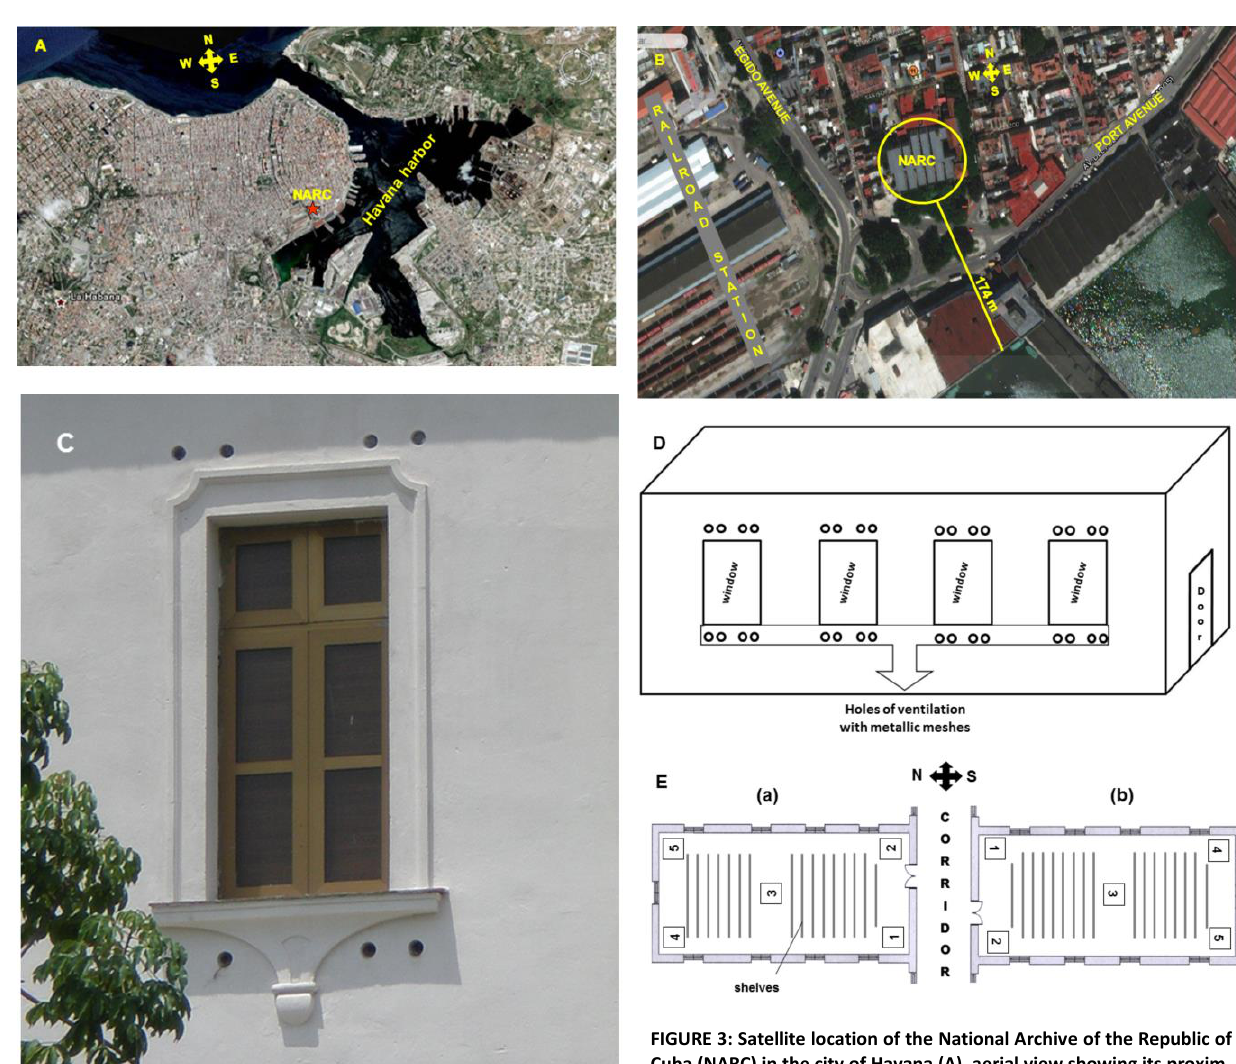
FIGURE 3: Satellite location of the National Archive of the Republic of Cuba (NARC) in the city of Havana (A), aerial view showing its proxim- ity to the sea, as well as the avenues and the vegetation that sur- round the building (B), photo (C) and schematic representation (D) of natural ventilation system openings location in the repositories as well as the microbiological sampling points (E) in each repository analyzed (a, b). At position (a) or north side of the building are reposi- tories R-8, R-20, R-28, and at position (b) or south part are repositories R-4, R-14,